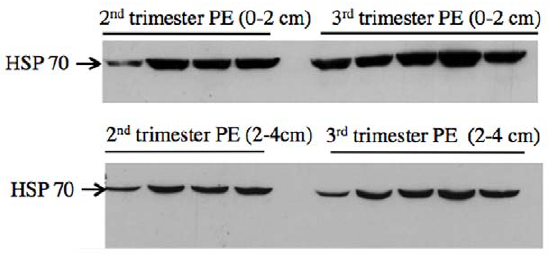
Figure 7. Shows a representative Western blot analysis of placental HSP 70 expression in 2 nd trimester preeclampsia cases versus 3 rd trimester preeclampsia cases measured at 0– 2 cm and 2–4 cm from the cord insertion point.